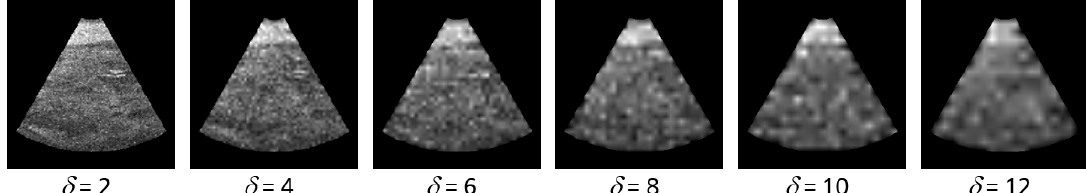
Figure 15. Synthetic images generated using uniform-grid sampling scheme with increasing values of the grid spacing parameter δ .